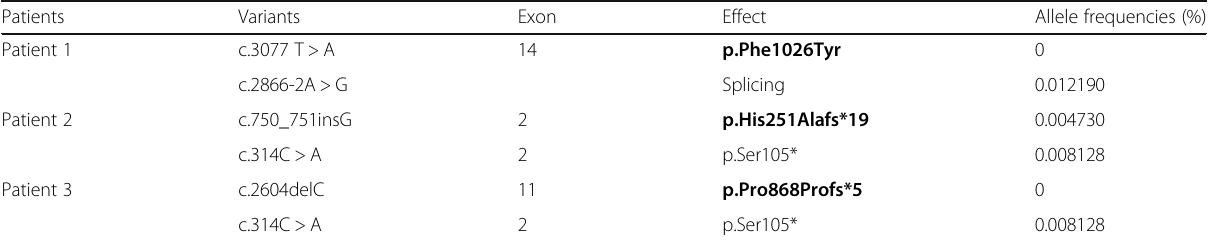
Table 1 GnomAD frequencies for the mutations Patients